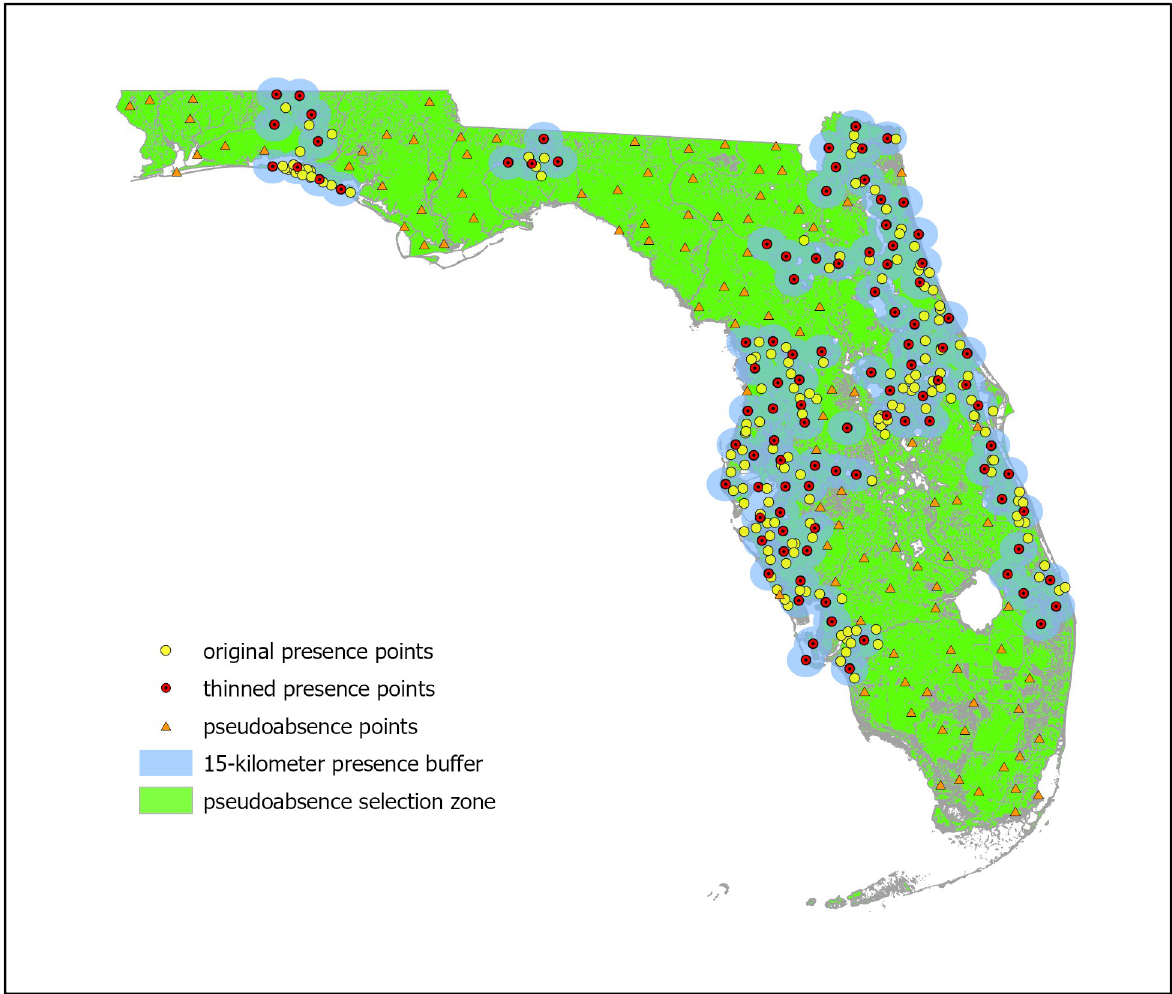
Fig 2. Presence and pseudoabsence points. The original and thinned presence points are indicated within the 15-kilometer buffer used for reduction of spatial autocorrelation. The remaining regions outside of the buffer constitute the pseudoabsence selection zone with the randomly selected pseudoabsence points